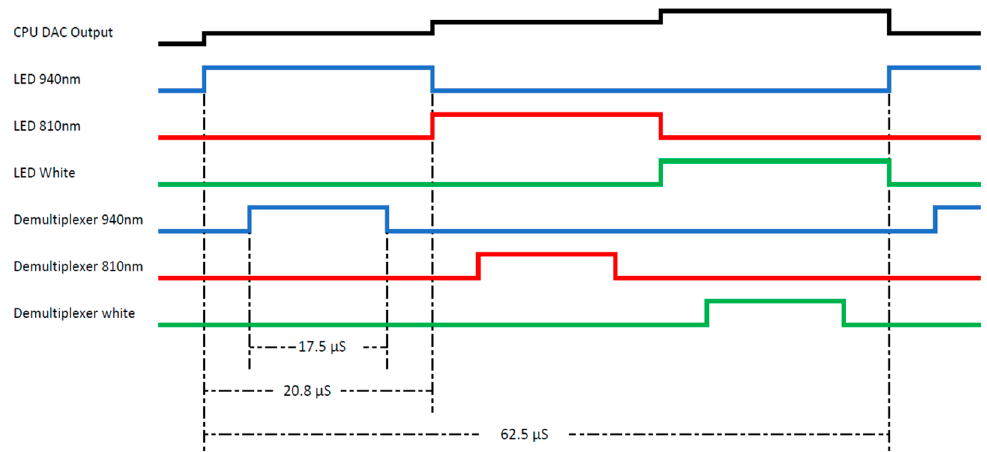
Figure 3. The CPU digital to analog converter (DAC) output defines the current level for each light pulse per spectral band. The signals LED 940 nm, LED 810 nm, and LED White initiate the output of the LED drivers for each spectral band. The signals: demultiplexer 940 nm, demultiplexer 810 nm, and demultiplexer-white initiate the corresponding sample and hold amplifier so that the photodiode is demultiplexed.